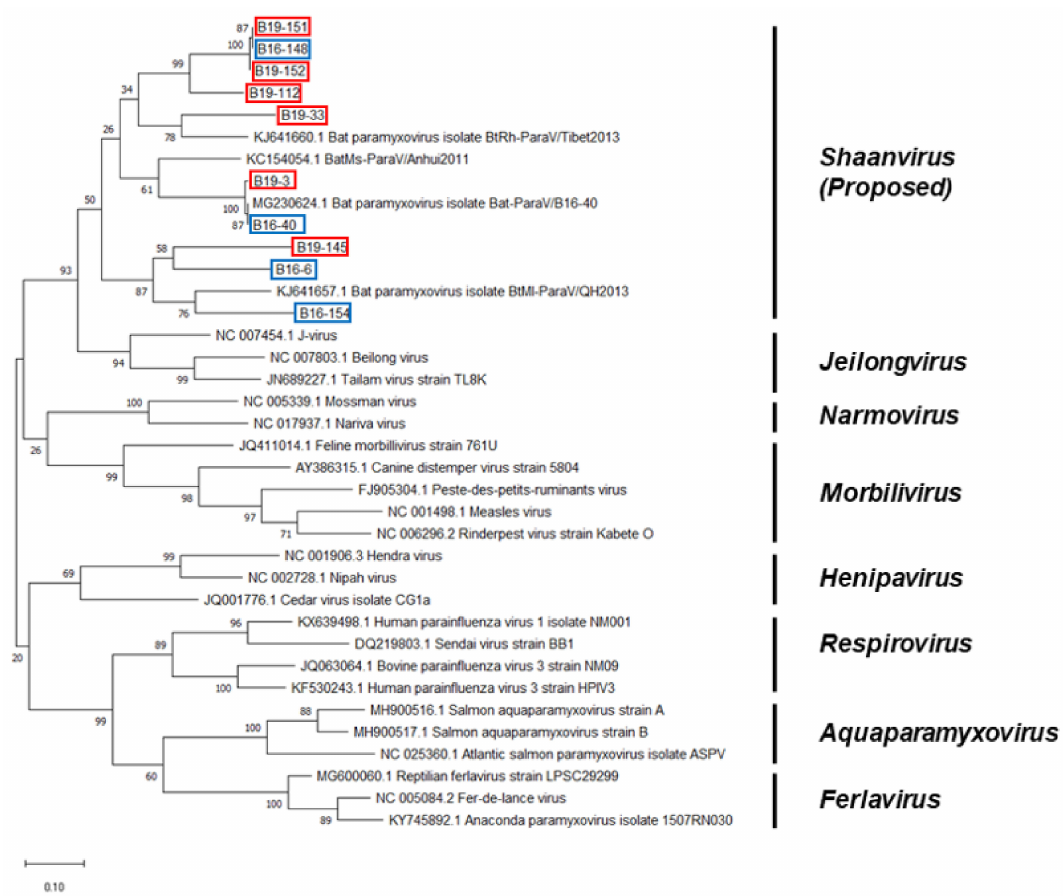
Figure 2. Phylogenetic analysis based on partial RNA-dependent-RNA-polymerase (RdRp) nucleotide sequences of bat paramyxoviruses detected in Korean bats and other reference viruses belonging to Paramyxoviridae . The phylogenetic tree was generated via the maximum-likelihood method with 1000 replicates of bootstrap sampling and Kimura 2-parameter model using MEGA X. Korean bat paramyxoviruses detected in 2016 are indicated by blue boxes. Korean bat paramyxoviruses detected in 2019 are indicated by red